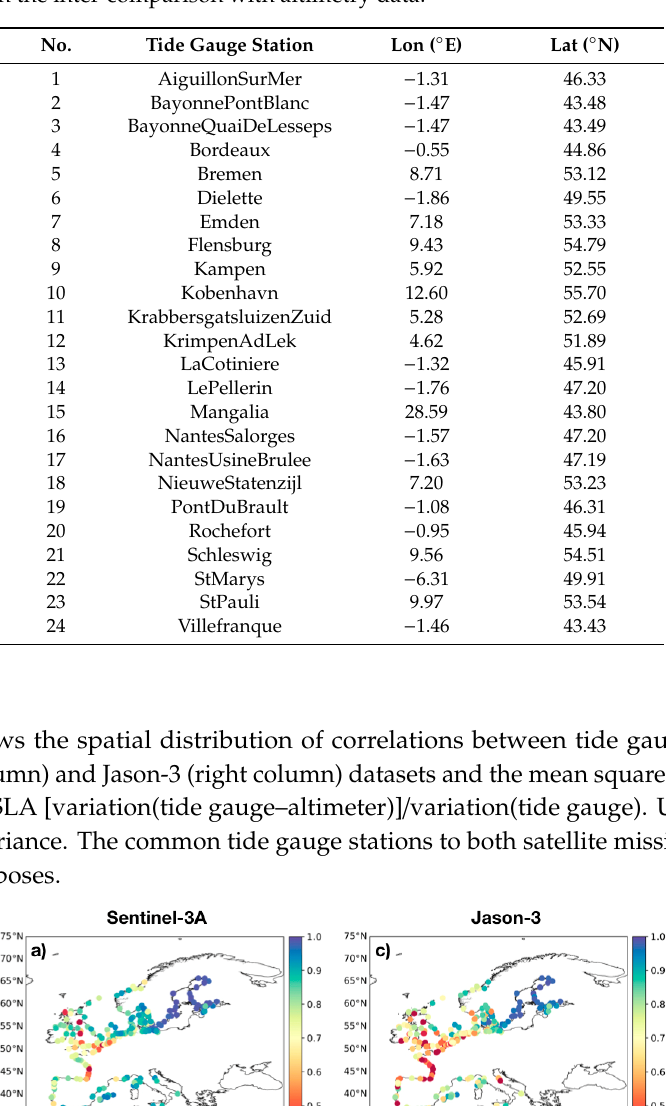
Table A2. Tide gauge stations from the cmEMS catalogue in the European Seas showing abnormal variance values in the inter-comparison with altimetry data.